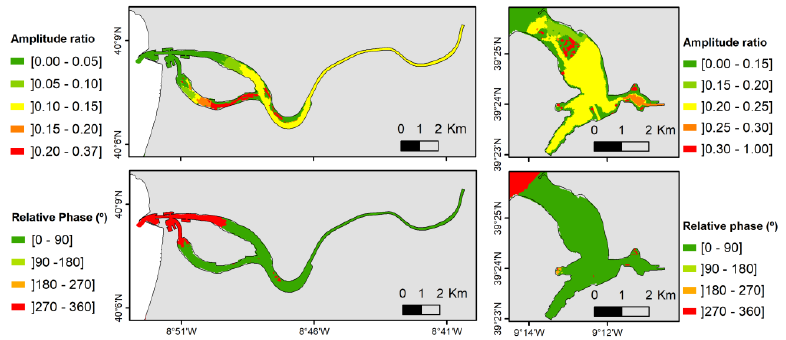
Figure 7. Amplitude ratio and relative phase (°) for Mondego Estuary (left) and Ó bidos Lagoon (right). Table 5. Tidal prism (m 3 ) computed at the mouth channel section for Mondego Estuary and Ó bi- dos lagoon. Mondego Estuary Óbidos Lagoon